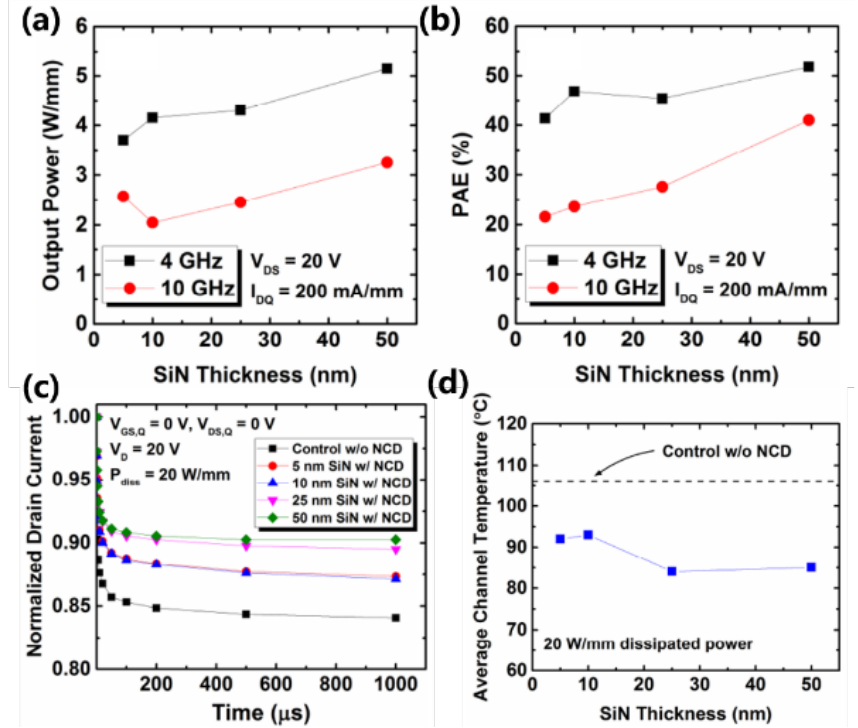
Figure 10. Thermal and electrical performance of NCD-coated HEMTs with different MBE SiN interlayer thicknesses. ( a ) Large-signal output power density. ( b ) Power-added efficiency measured for 4 GHz and 10 GHz at peak PAE. ( c ) Normalized cold-pulsed drain current transient measurements. ( d ) Calculated average channel temperature at 20 W/mm of dissipated power. The control HEMT has no NCD coating and a 125 nm PECVD SiN passivation layer [116].